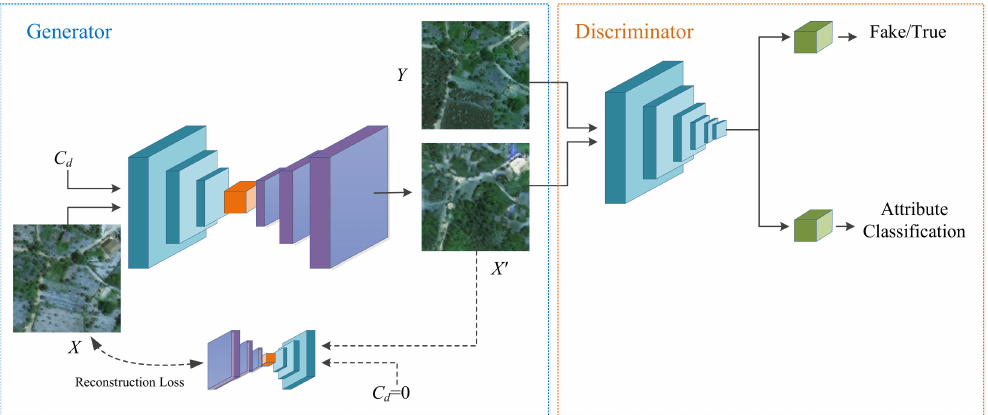
Figure 1. The architecture of disaster translation GAN, including generator G and discriminator D . D has two objectives, distinguishing the generated images from the real images and classifying the disaster attributes. G takes in as input both the images and target disaster attributes and generates fake images, with the inverse process that reconstructing original images with fake images given the original disaster